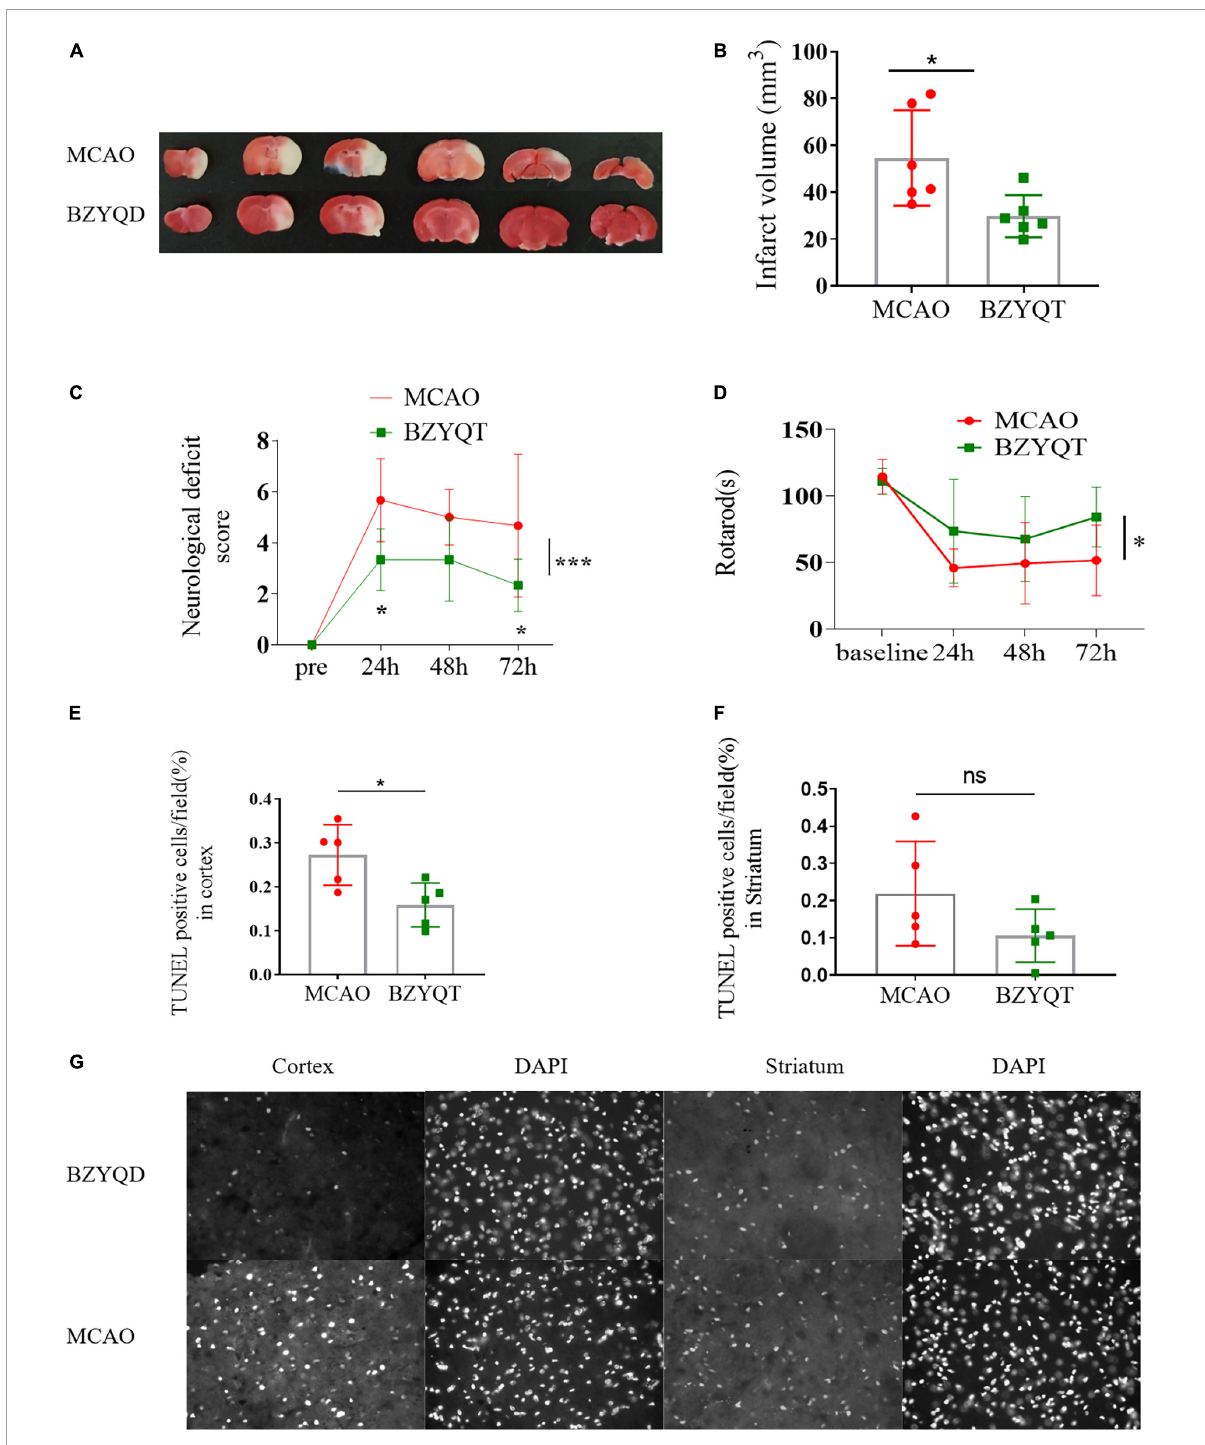
FIGURE2 Inhibition of focal ischemic strokes caused by middle cerebral artery obstruction Through BZYQD Preventive Therapy. (A) Representative images and (B) quantitation of infarct volume in TTC-stained coronal sections of mouse brains with a 45-min MCAO followed by 72 h of reperfusion. (C) Modified neurological severity score (mNSS) test was evaluated before and 24, 48 and 72 h after MCAO using the modified neurological score (mNSS). (D) Analysis of motion and balance function by rotarod test before and 24, 48 and 72 h after MCAO. The numerical assessment of terminal-deoxynucleoitidyl transferase mediated nick end labeling (TUNEL)-positive cells in the cortex (E) and striatum (F) near the cerebral infarction. (G) The representative photographs of apoptosis-positive cells using TUNEL staining in the cerebral cortex (cortex) and striatum (striatum) of the BZYQT group and the con group, and DAPI is the nucleus of the same part of the field of view. All statistical graphs: * p < 0.05, *** p < 0.0005. Data are presented as x − ± s, n =